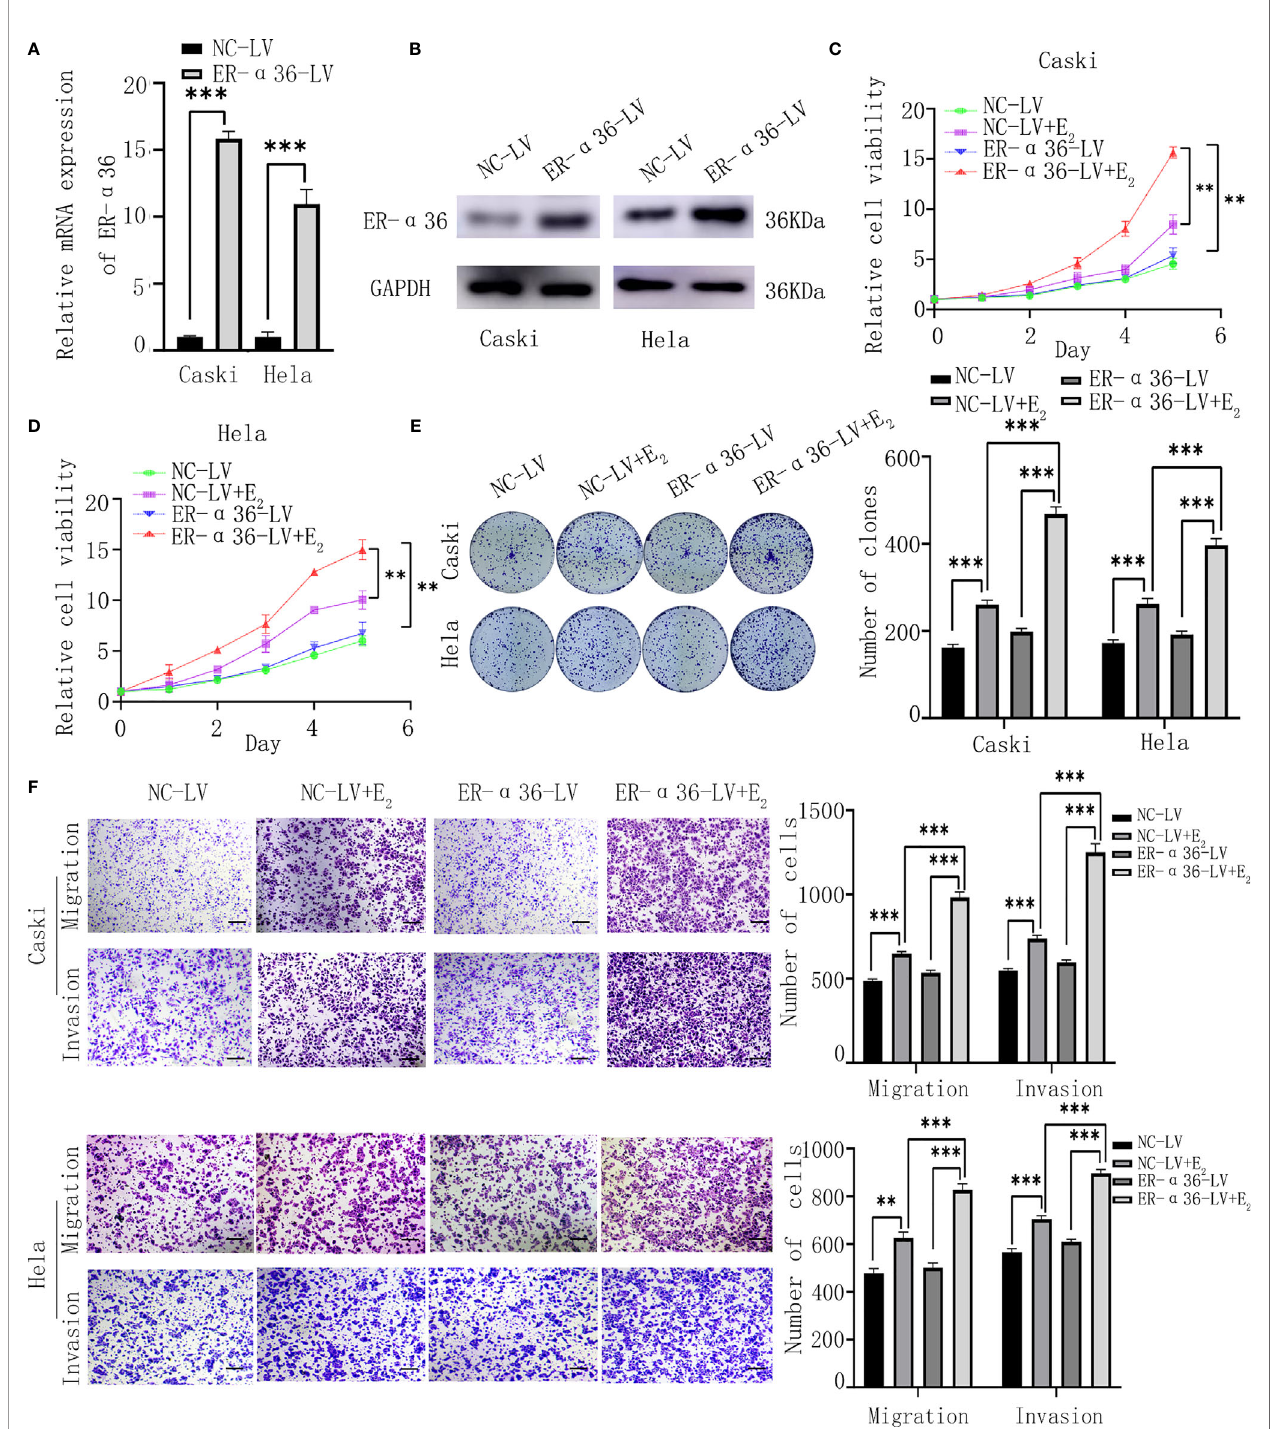
FIGURE 3 | ER- a 36 overexpression promotes E 2 -mediated proliferation and metastasis of CC cells in vitro . Caski, hela cells were stably transfected with NC-LV, ER- a 36-LV and treated with ethanol or 1nM E 2 . (A, B) qRT ‐ PCR and western blotting analysis of the mRNA and protein levels of ER- a 36 in transfected caski and hela cells. (C – E) Proliferation of caski and hela cells was measured by CCK-8 assay and clonogenic assay after ER- a 36 overexpression. (F) Migration and invasion of caski and hela cells were evaluated by transwell assay after ER- a 36 overexpression. Scale bar: 50 m m. (Data are mean ± SEM, **p < 0.01, ***p < 0.001, n =